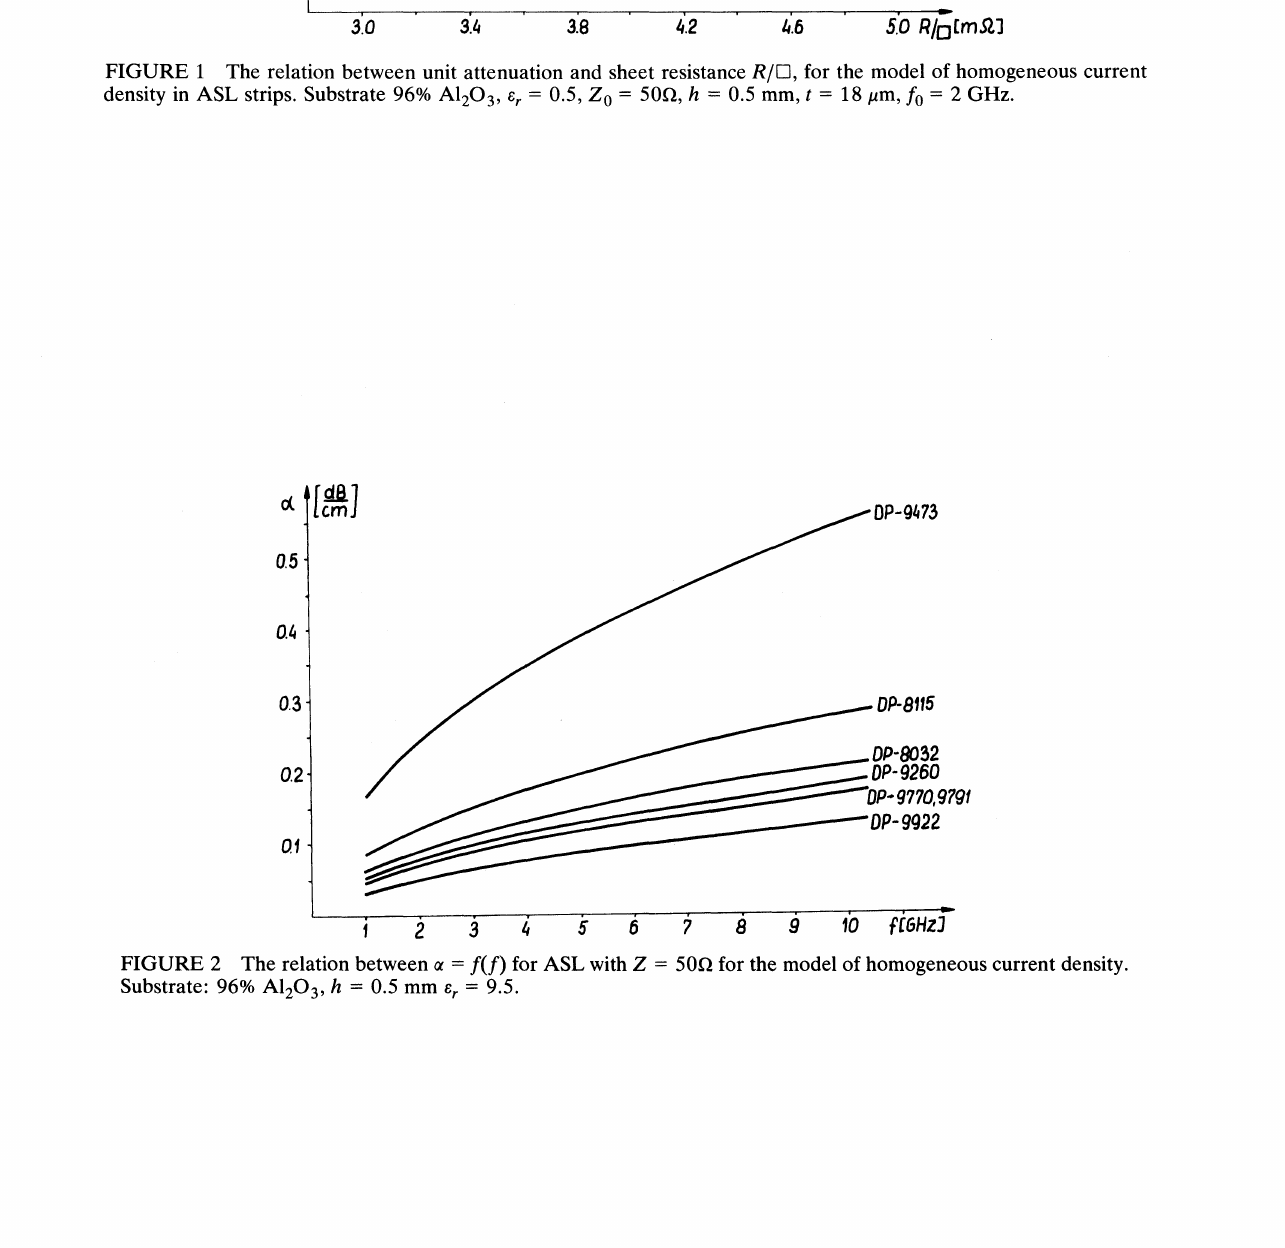
FIGURE 2 The relation between f(f) for ASL with Z 50 for the model of homogeneous current density. Substrate: 96% A120 3,